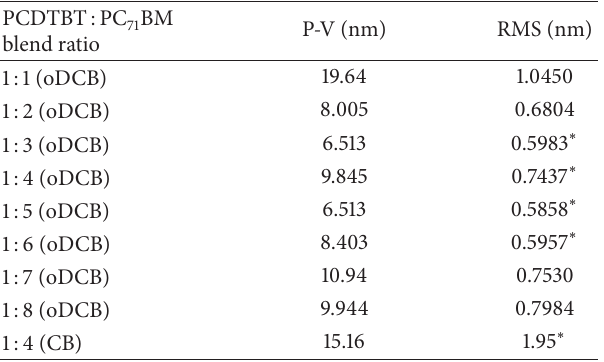
Table 1: Surface roughness parameters of the PCDTBT:PC prepared with different mixing ratios of 1: 1 ∼ 1:8 in o-DCB and CB.